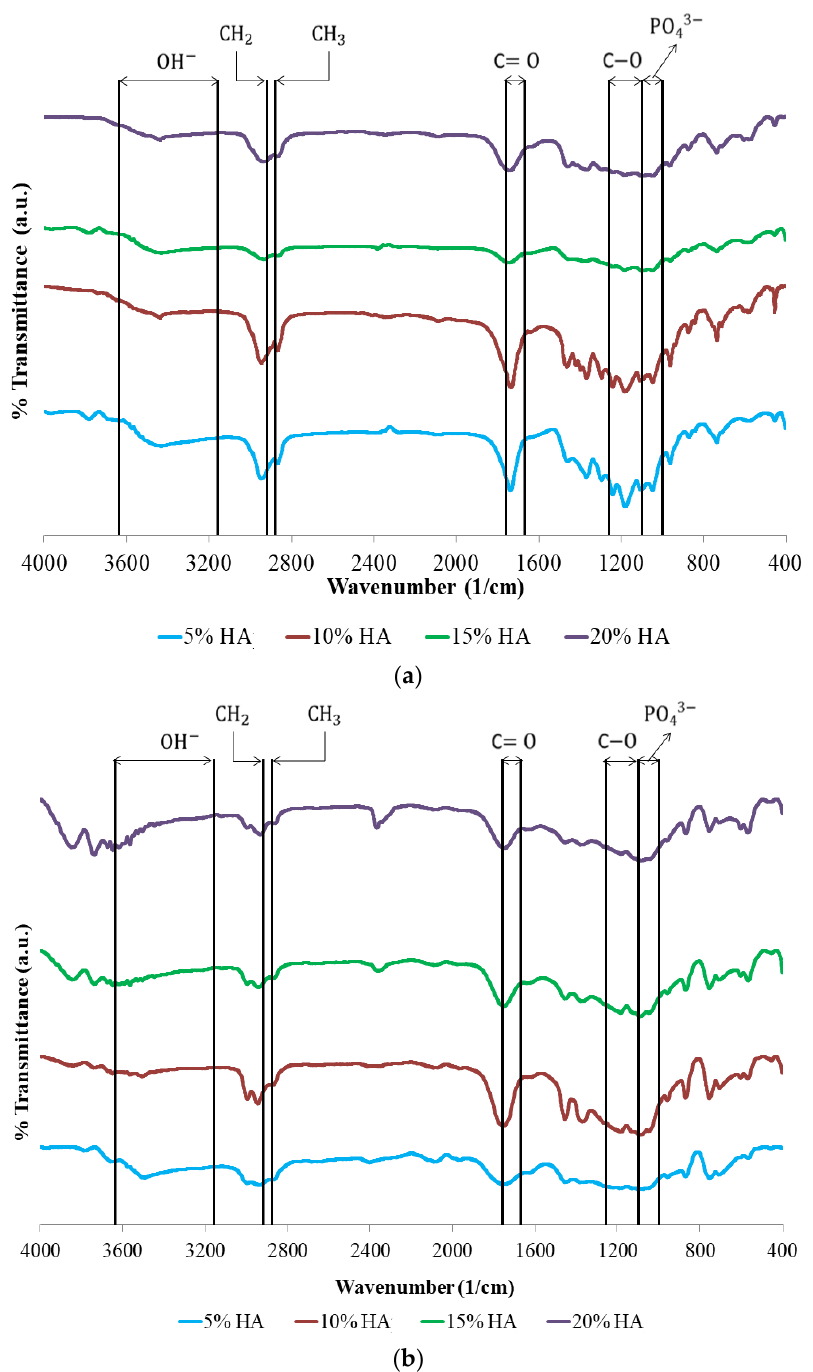
Figure 3. FTIR spectra of biocomposites of ( a ) PLA40/PCL60 and ( b ) PLA85/PCL15 at various concentrations of HA.